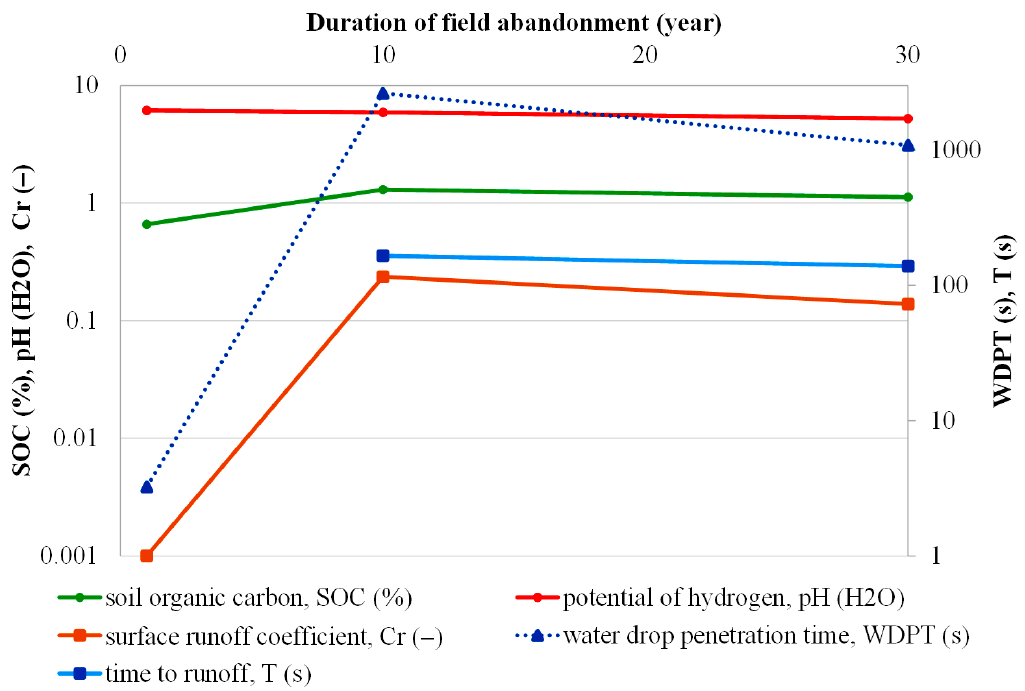
Figure 3. Relationships between soil organic carbon (SOC) content, pH (H 2 O), water drop penetration time, WDPT, time to runoff, T , and surface runoff coefficient, C r , estimated in the top layer of acidic sandy soils, and duration of field abandonment at experimental sites S1, S2, and S3 located at Studienka village in the Borská nížina lowland (southwestern Slovakia). Note that both vertical axes have a logarithmic scale.